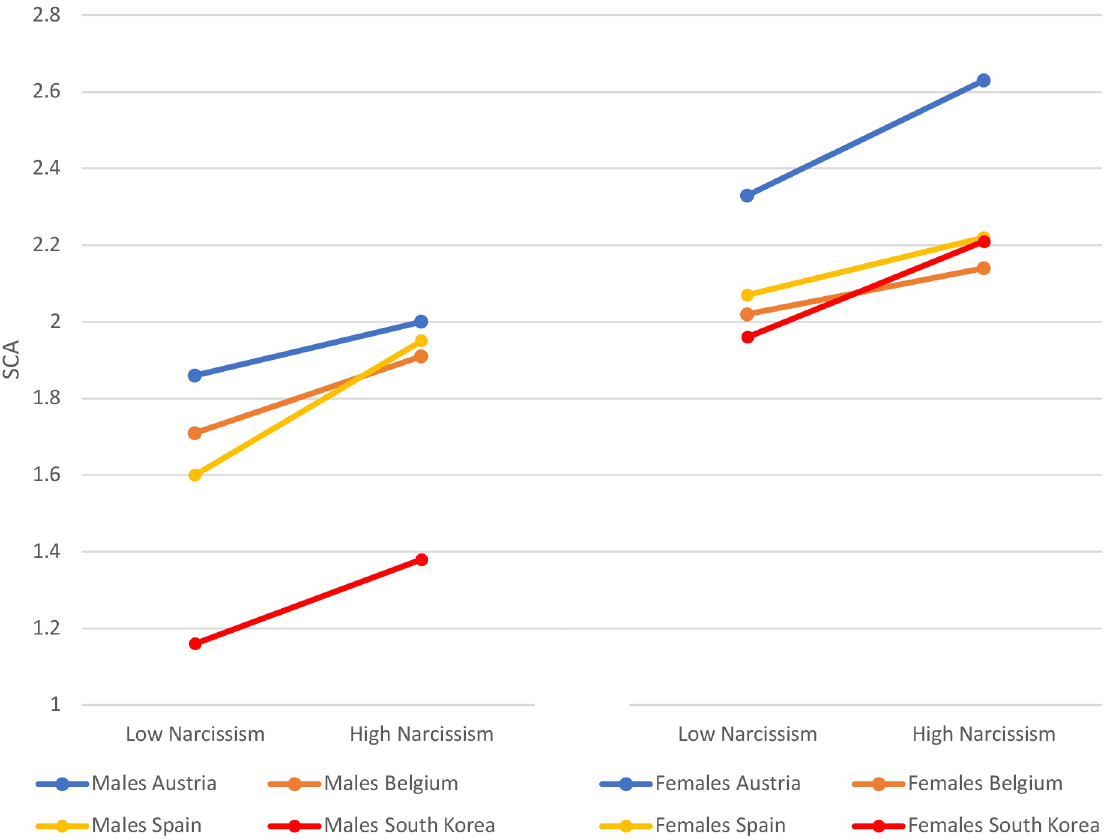
Fig 8. Self-centered appearance focused use of social media (SCA) among low/high narcissism boys and girls by countries.